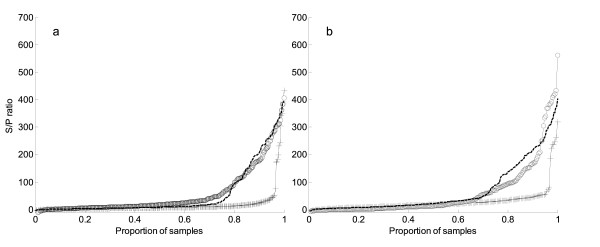
N. caninum S/P ratio against proportion of samples (positivity ramps) for two different herds in the study that had an outbreak between visit one and visit two. Black crosses and line represents first routine visit black circles and line represents second routine visit and the black line represents the third routine visit for each herd (Dataset B – 26,437 samples, 13,942 cattle, 114 herds, only cattle ≥ 2 years old for regular visits in the 4-year study period).